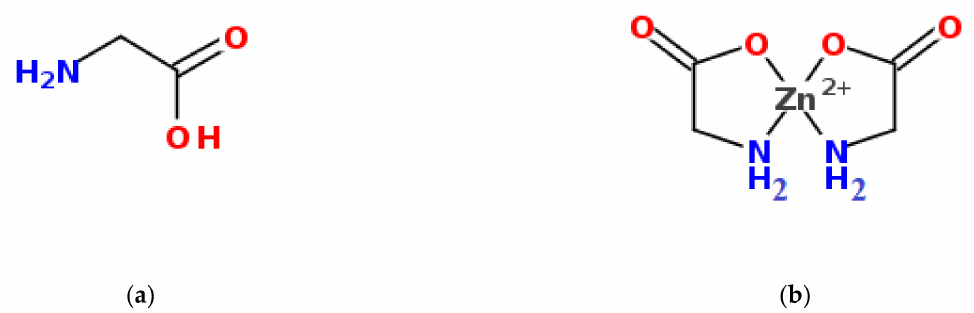
Figure 1. Chemical structures of glycine ( a ) and its zinc chelate compound—zinc glycinate ( b ).